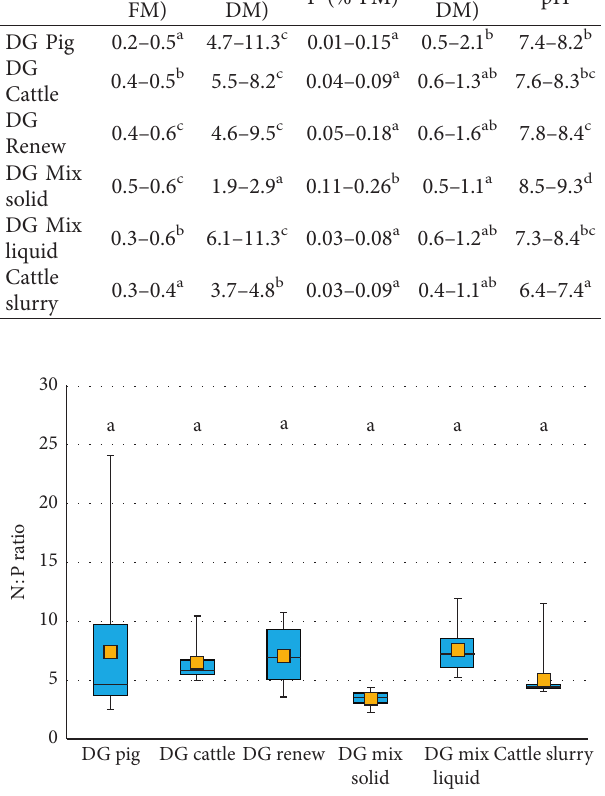
Figure 1: Range of N :P ratio of five digestates and cattle slurry (analyzed twice a year over six years; therefore, n � 12 (DG Mix liquid five years, n � 10), and different letters above bars mark significant differences between means (Scheff´e’s test, p ≤ 0 .